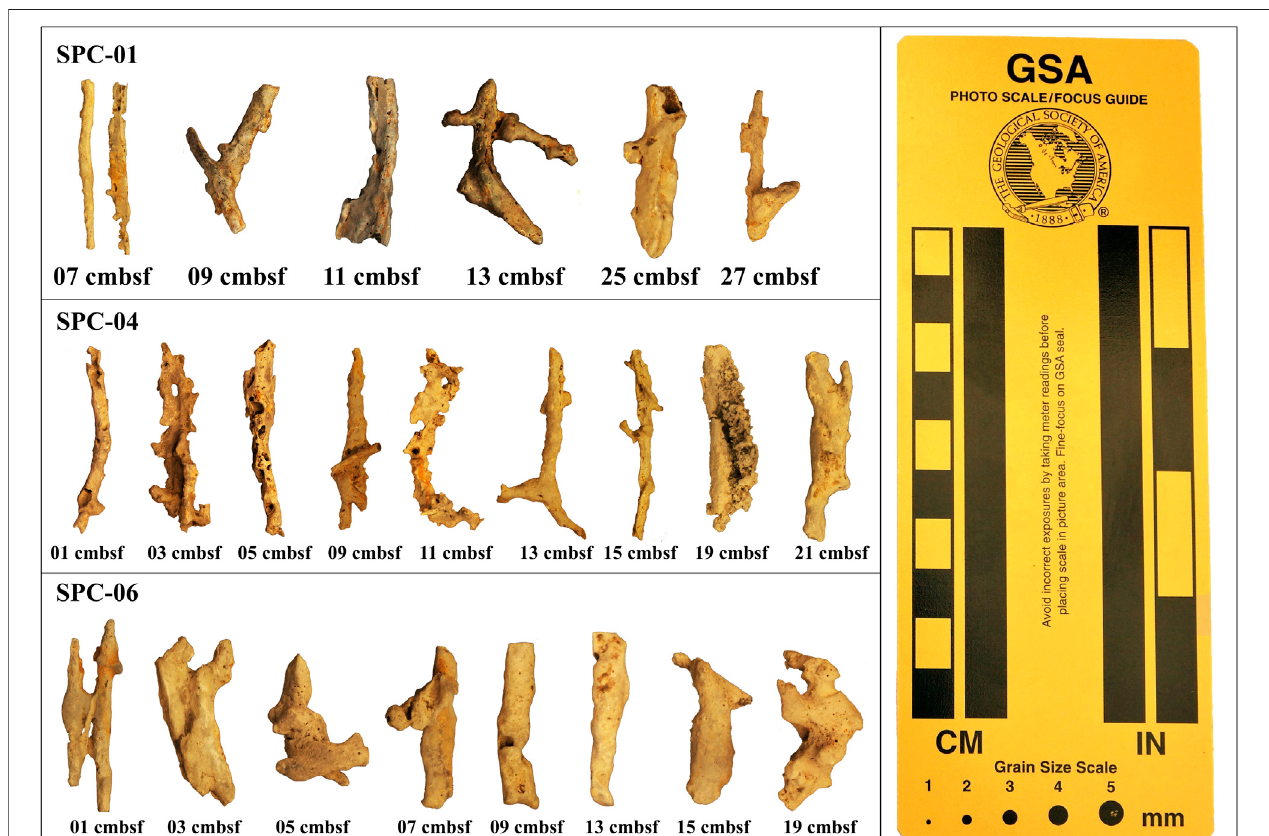
FIGURE 13 | Photographs showing methane-derived authigenic carbonates found in an active seep sites SSD-45/Stn-04/SPC-01, SPC-04 and SPC-06. Respective depths of the carbonate occurrence are mentioned.